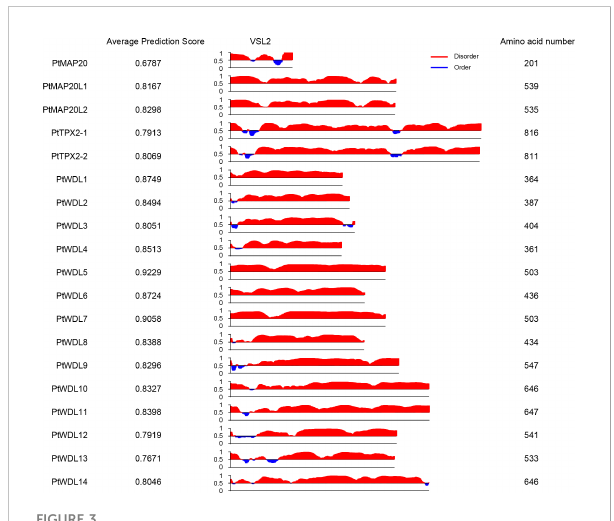
FIGURE 3 Intrinsically disordered regions prediction of 19 PtTPX2